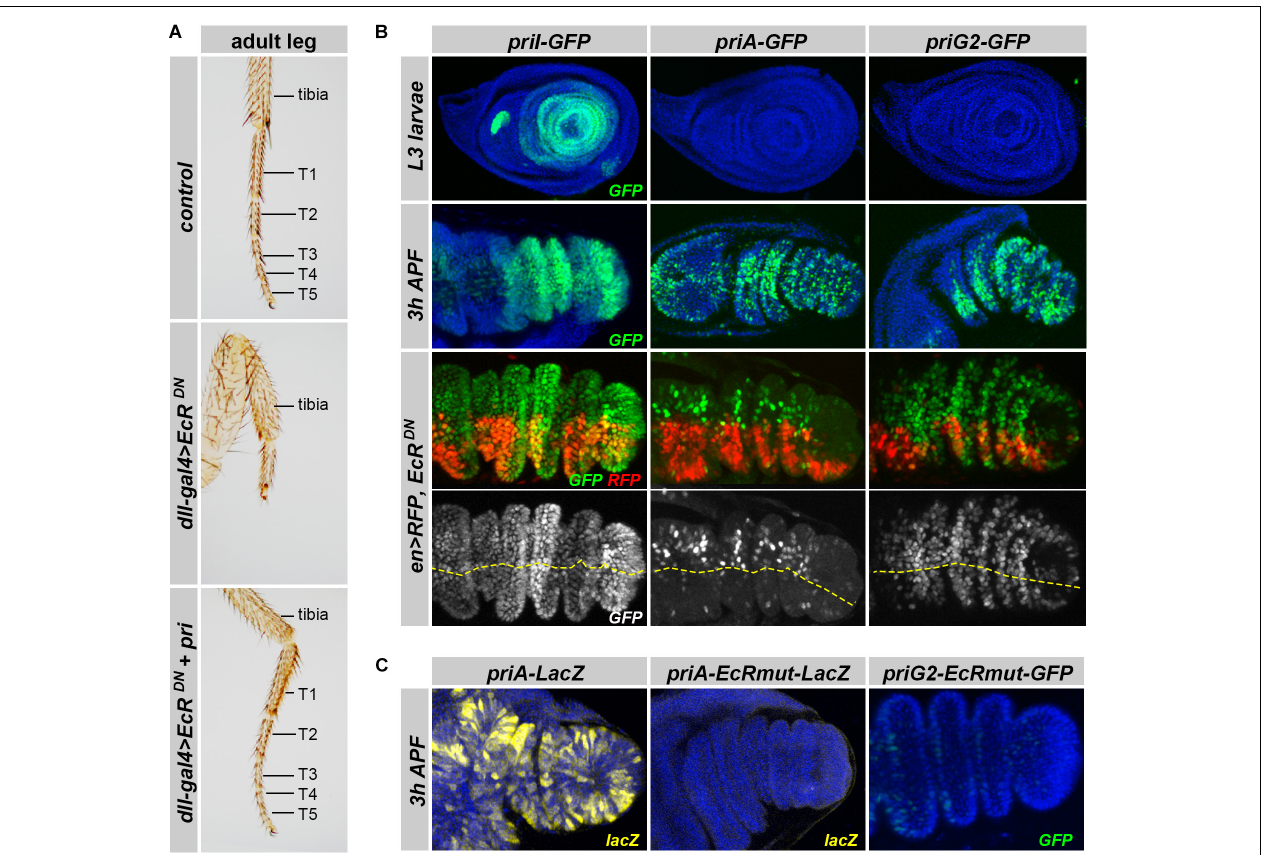
FIGURE 6 | Expression of pri enhancers active in leg primordia at the larval/prepupal transition. (A) Pictures of adult forelegs in control individuals or animals expressing EcR DN under the control of dll-gal4 , with or without simultaneous expression of pri mRNA. T1–5 represents tarsal segments. (B) Activity of priI , priA , and priG2 enhancers (green) in control leg disks (upper panels) at mid L3 and pupal (3–5 h APF) stages (two top panels). The two bottom panels show the effect of expressing EcR DN under the control of en-Gal4 [that also drives RFP (red)] on the activity of priI , priA , and priG2 enhancers in pupal leg disks. DAPI is in blue. The yellow line highlights the boundary between RFP-positive (posterior compartment) and RFP-negative (anterior) cells. (C) Effect of inactivating EcR binding sites on the activity of priA (ß-Gal immunostaining, yellow) and of priG2 (GFP, green) in the pupal leg primordium. Nuclei are visualized by DAPI (blue).